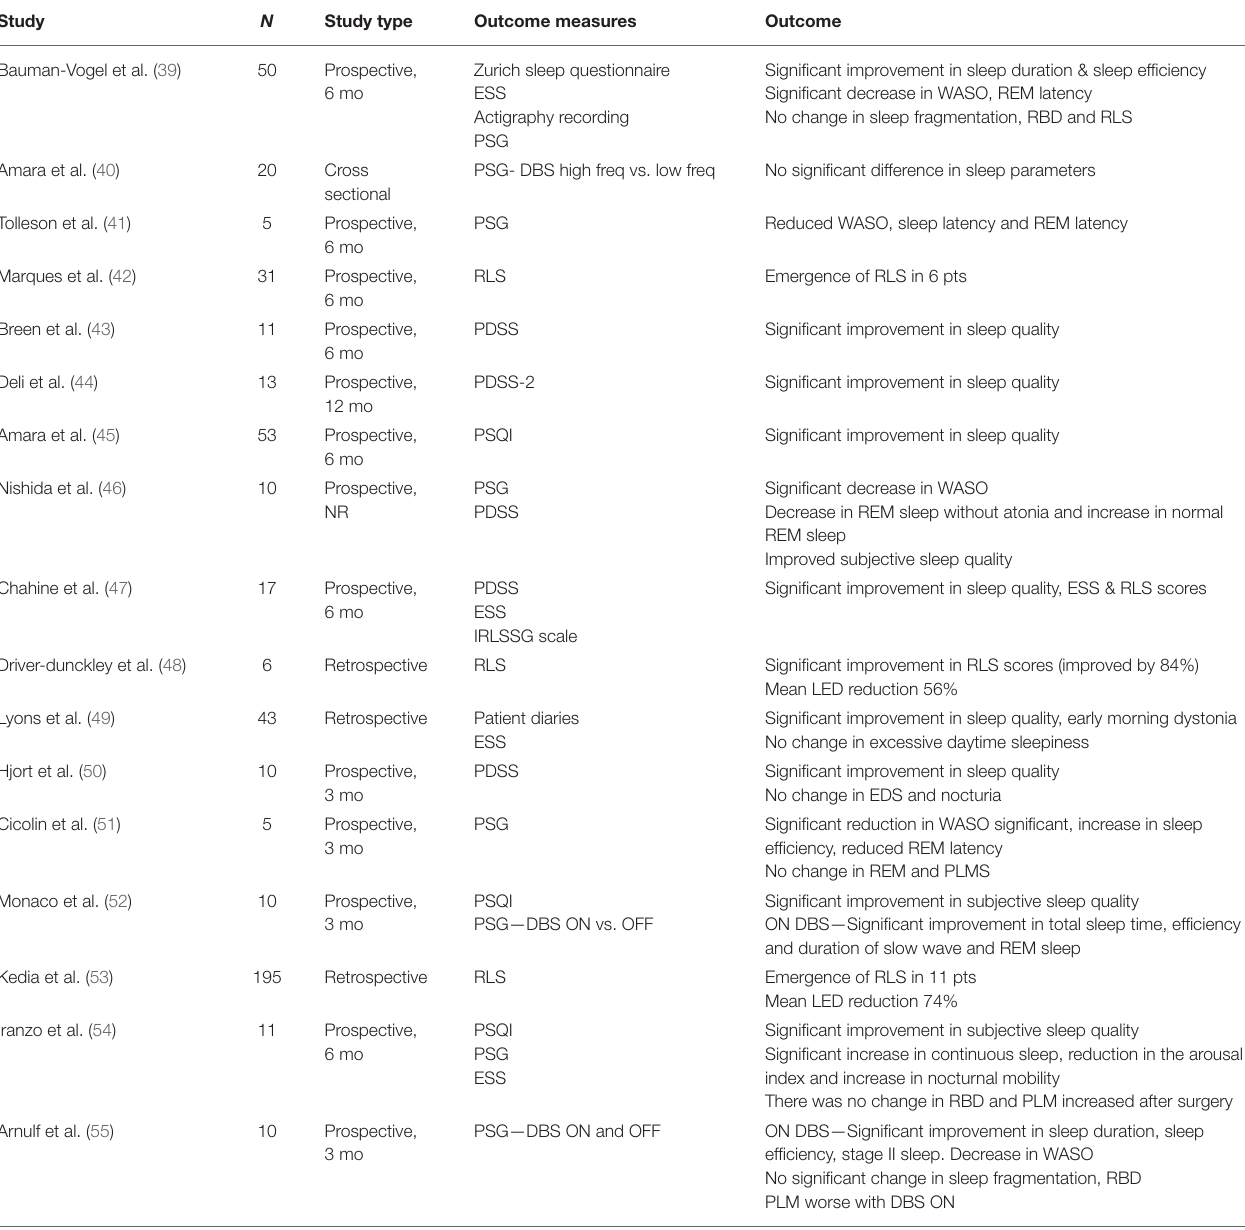
TABLE 1 | Summary of studies examining the effects of STN DBS on